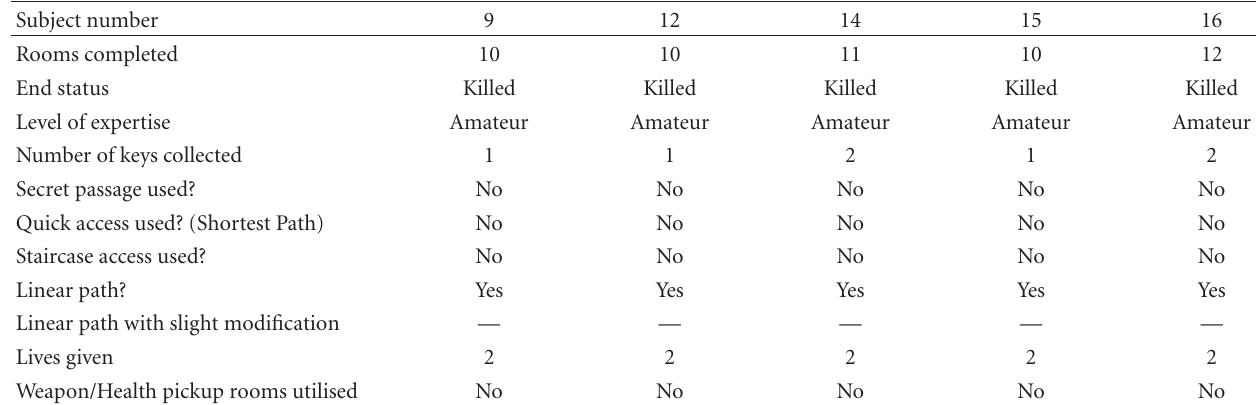
Table 4: The performance of the five worst